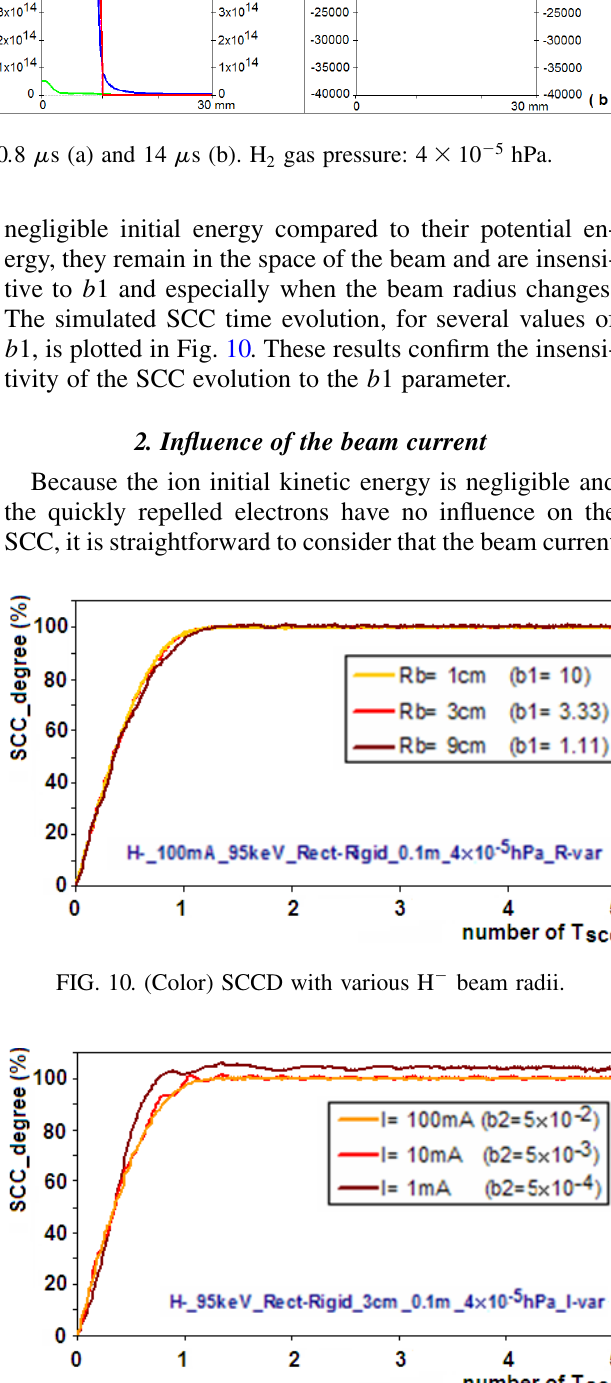
FIG. 9. (Color) Plasma and SC evolution of an H (cid:2) beam at 0 : 8 (cid:6) s (a) and 14 (cid:6) s (b). H